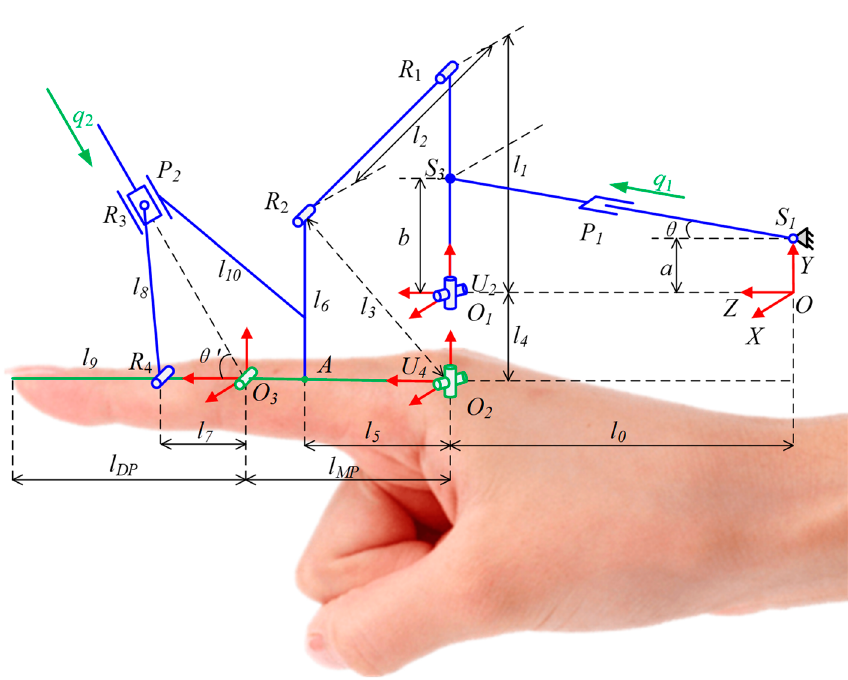
Figure 5. The schematic diagram of the index finger rehabilitation mechanism.